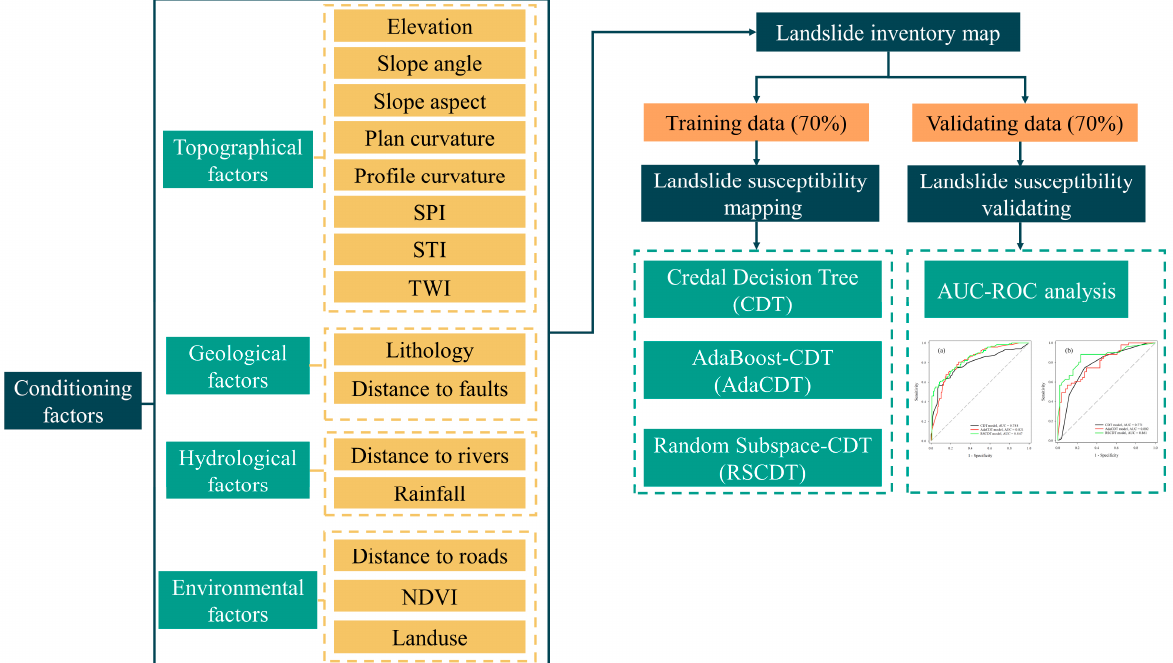
Figure 2. Methodological flowchart of the landslide susceptibility mapping used in the study.